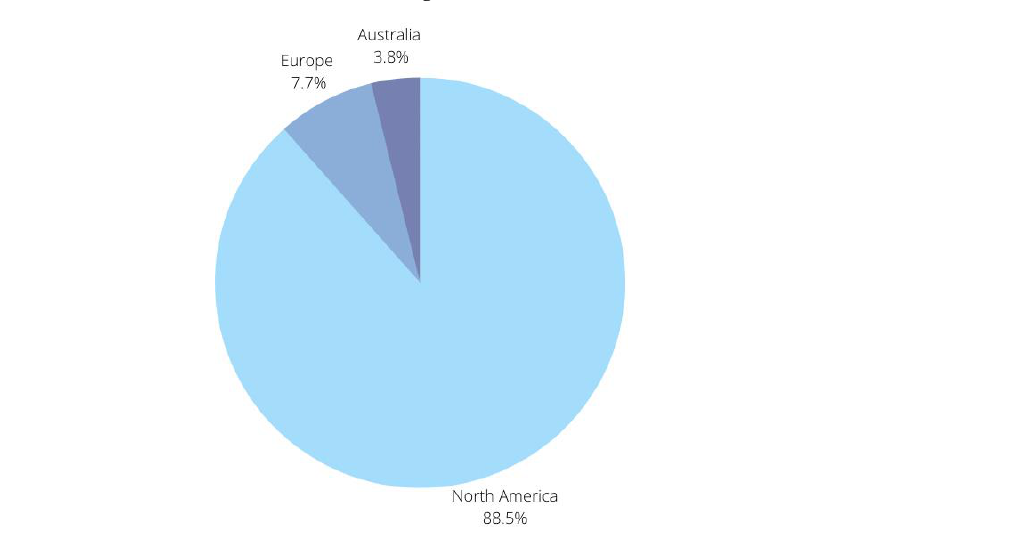
Figure 2. Summary of continents selected for study. Table 1. Characteristics of the included